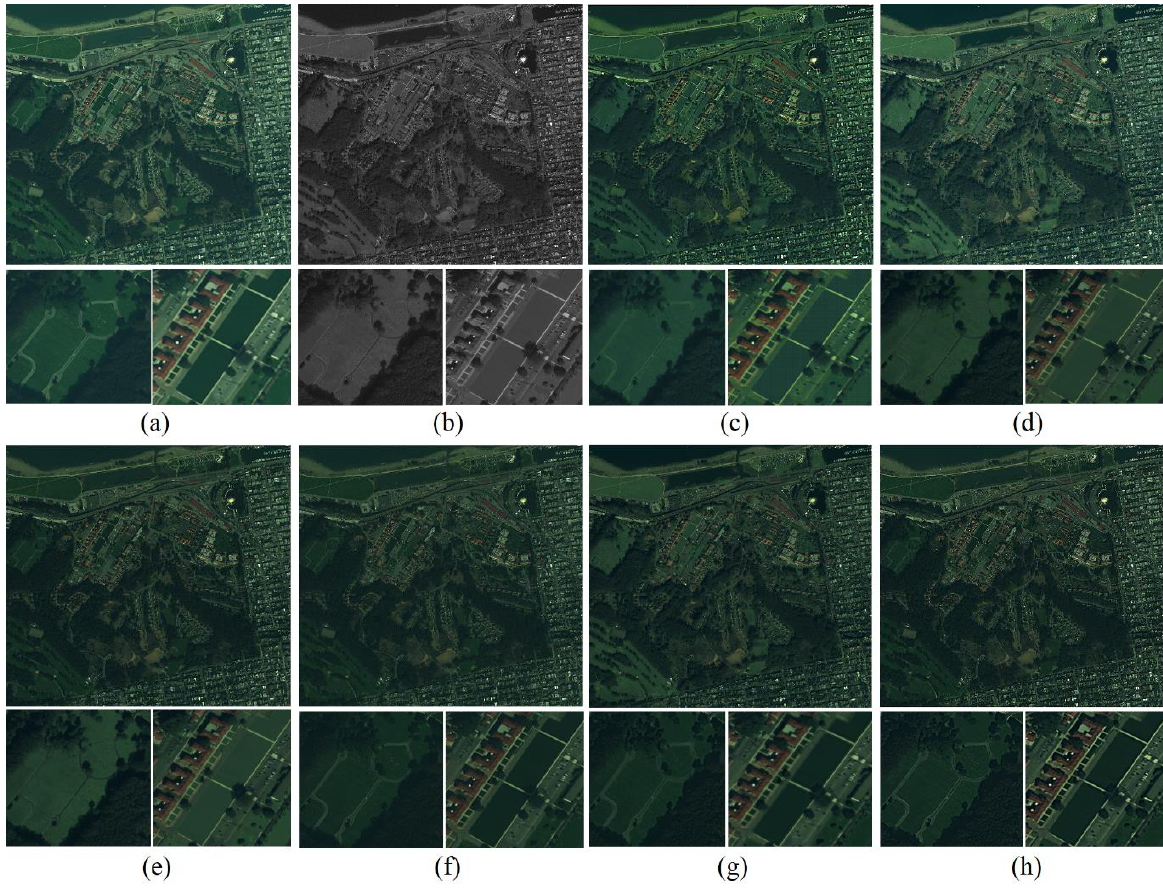
Figure 6. The inputs and outputs of pan-sharpening methods: (a) Multi-spectral, (b) Panchromatic, (c) Fuzzy-DWT, (d) PCA, (e) GS,